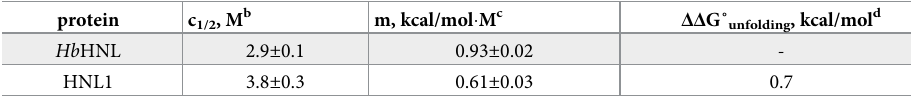
Fig. This 25–35 ˚C difference in inactivation temperature indicates that HNL1 effectively resists irreversible aggregation even when all the protein is unfolded. Urea-induced unfolding measurements confirm that HNL1 is more stable than Hb HNL and suggest that unfolded HNL1 retains more folded structure than Hb HNL, Table 2 (S5 Fig shows experimental data). The concentration of urea required to unfold half of the proteins is higher for HNL1 (3.8 ± 0.3 M) than for Hb HNL (2.9 ± 0.1 M), which indicates that HNL1 is more stable than Hb HNL. The m-value for the urea unfolding experiment (absolute value of the slope of the plots in S5 Fig panel B), which indicates the sensitivity of the protein to urea and depends on the solvent accessible surface area exposed upon unfolding [49], is signifi- cantly higher for Hb HNL (0.93 ± 0.02 kcal/mol � M) than for HNL1 (0.61 ± 0.03 kcal/mol � M). The Table 2. Urea-induced unfolding of Hb HNL and HNL1 a